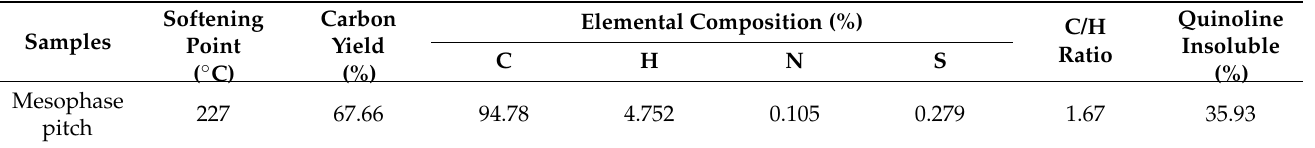
Table 1. Physical properties and elemental composition of mesophase